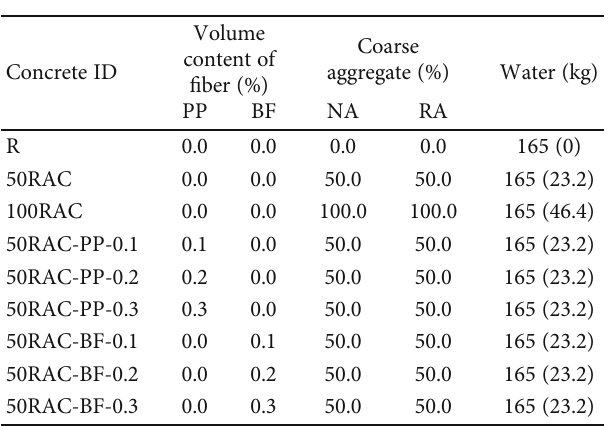
Table 6: Mix proportions of reference concrete and